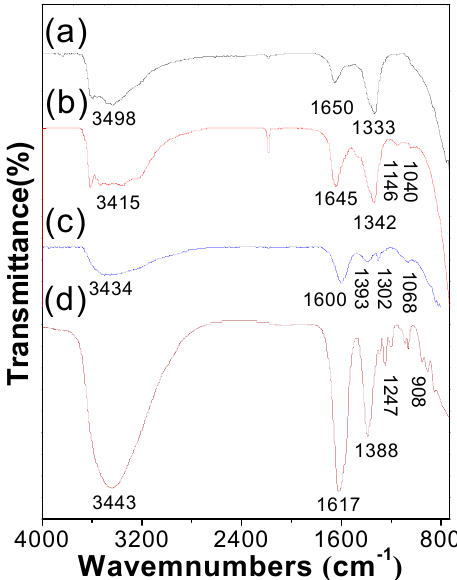
Figure 2. FTIR spectra of ( a ) NiFe–LDH films, ( b ) NiAl–LDH films, ( c ) Fe-doped NiAl–LDH films, and ( d ) Fe-doped NiFe–LDH films.